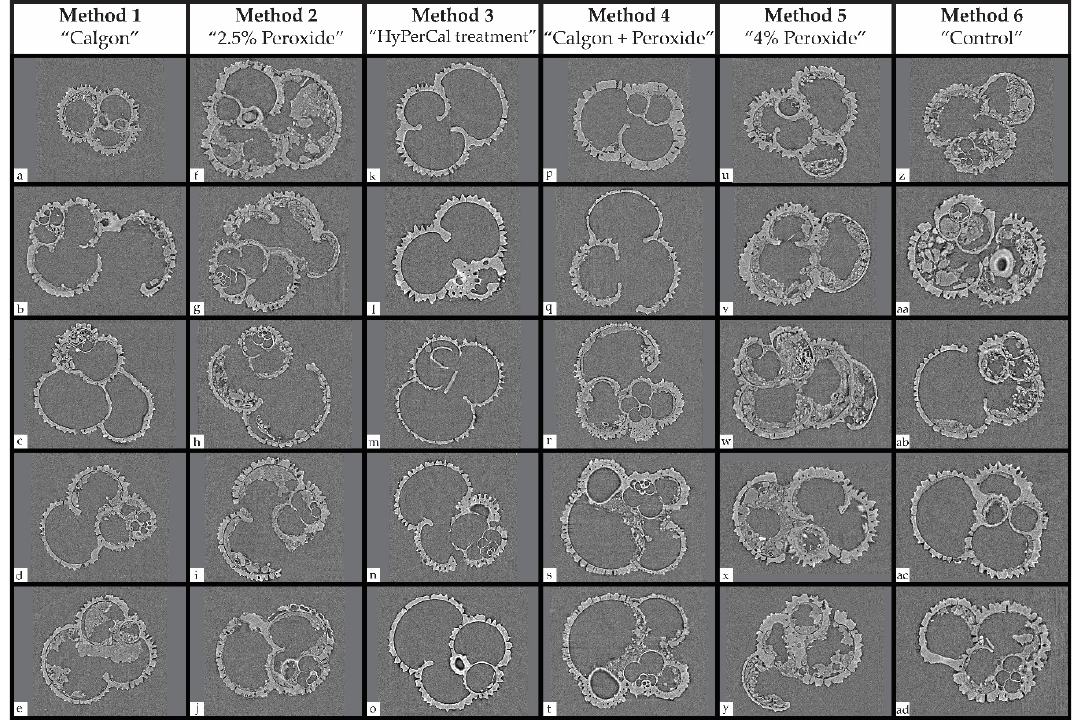
Figure 3. X-ray tomographic images of the interior of the specimens after their treatment with the di ff erent cleaning methods: ( a – e ) tomographs of specimens after treatment with Na 6 O 18 P 6 , ( f – j ) tomographs of specimens after treatment with 2.5% H 2 O 2 solution, ( k – o ) tomographs after treatment first with 2.5% H 2 O 2 and subsequently with Na 6 O 18 P 6 solution (HyPerCal), ( p – t ) tomographs after treatment simultaneously with 2.5% H 2 O 2 and Na 6 O 18 P 6 solution, ( u – y ) tomographs after treatment with 4% H 2 O 2 , and ( z – ad ) tomographs after treatment with only with distilled water. Table 2. Table showing the results of the X-ray tomographic and weight analyses. The degree of contamination is given as a percentage of cell’s volume. Furthermore, the di ff erence in the measured weights in regard to the average shell weight of the least contaminated